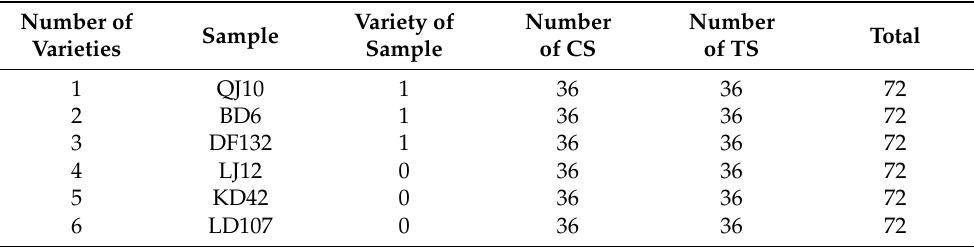
Table 1. Variety and quantity of test samples (1: saline-alkali-tolerant, 0: saline-alkali-sensitive, CS: control sample, TS: treated sample).